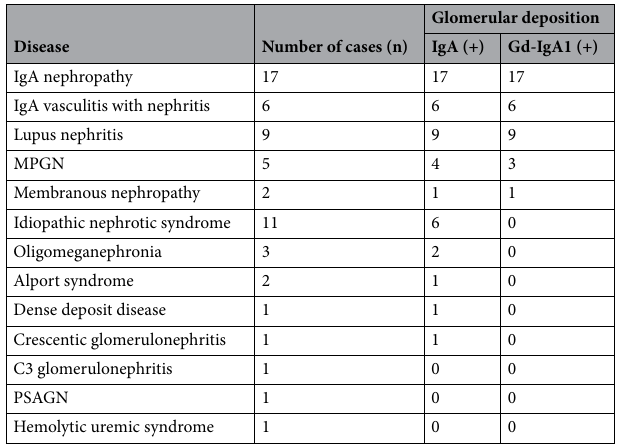
Table 1. Numbers of patients with IgA-positive and Gd-IgA1-positive disease. MPGN membranoproliferative glomerulonephritis, PSAGN poststreptococcal acute